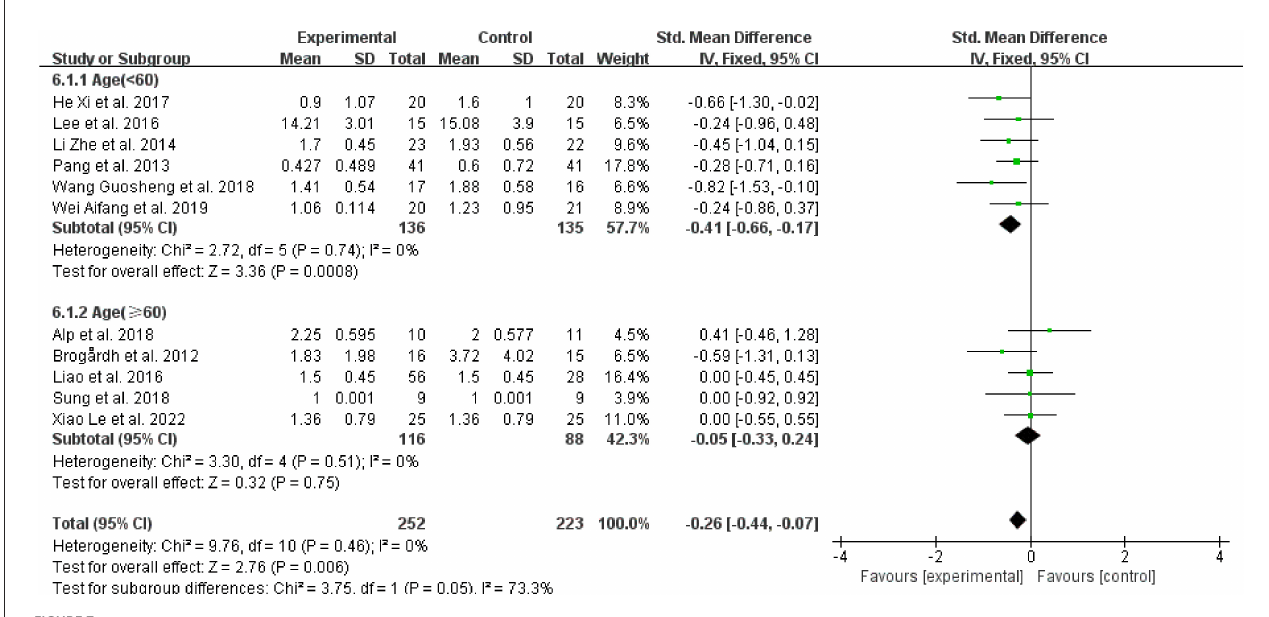
FIGURE7 Forest plot analysis of the efficacy of WBV in subgroups divided on the basis of age.